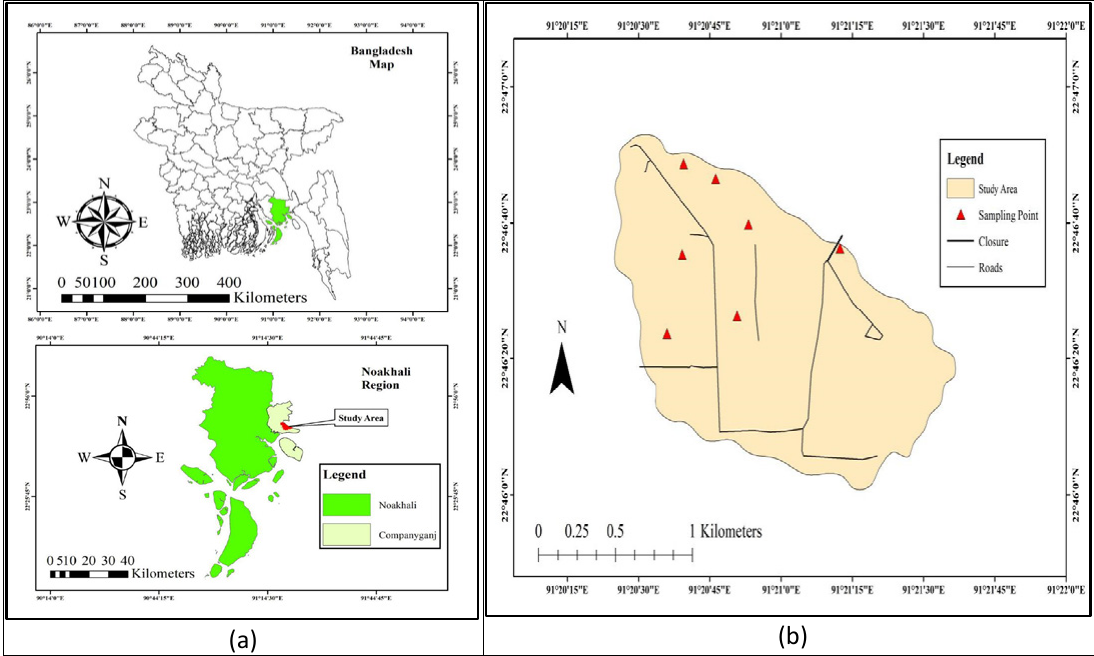
Fig. 1: Map of the study area (a) Companiganj Upazila (b) sampling points of Musapur Union (Base map was retrieved from LGED